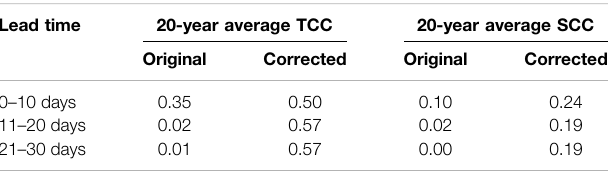
TABLE 1| The20-yearaverageTCC(SCC) fortheoriginaland bias-corrected10- day moving accumulated precipitation anomaly predictions over Eastern China shown in Figures 3 – 5 ( Figure 9J ).